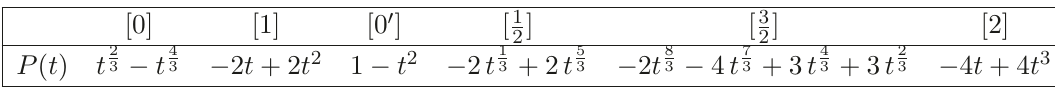
P ( t ) of the = 1 (1 − t ) 2 N